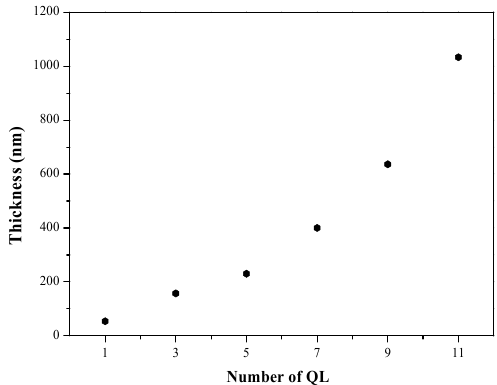
Figure 12. Thickness as a function of QLs deposited on PET films.